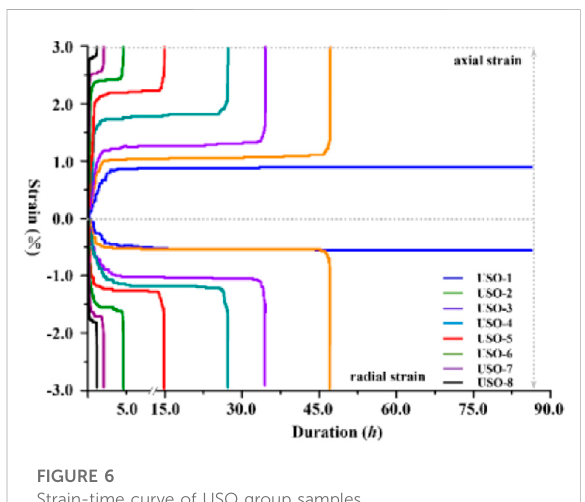
FIGURE 6 Strain-time curve of USO group